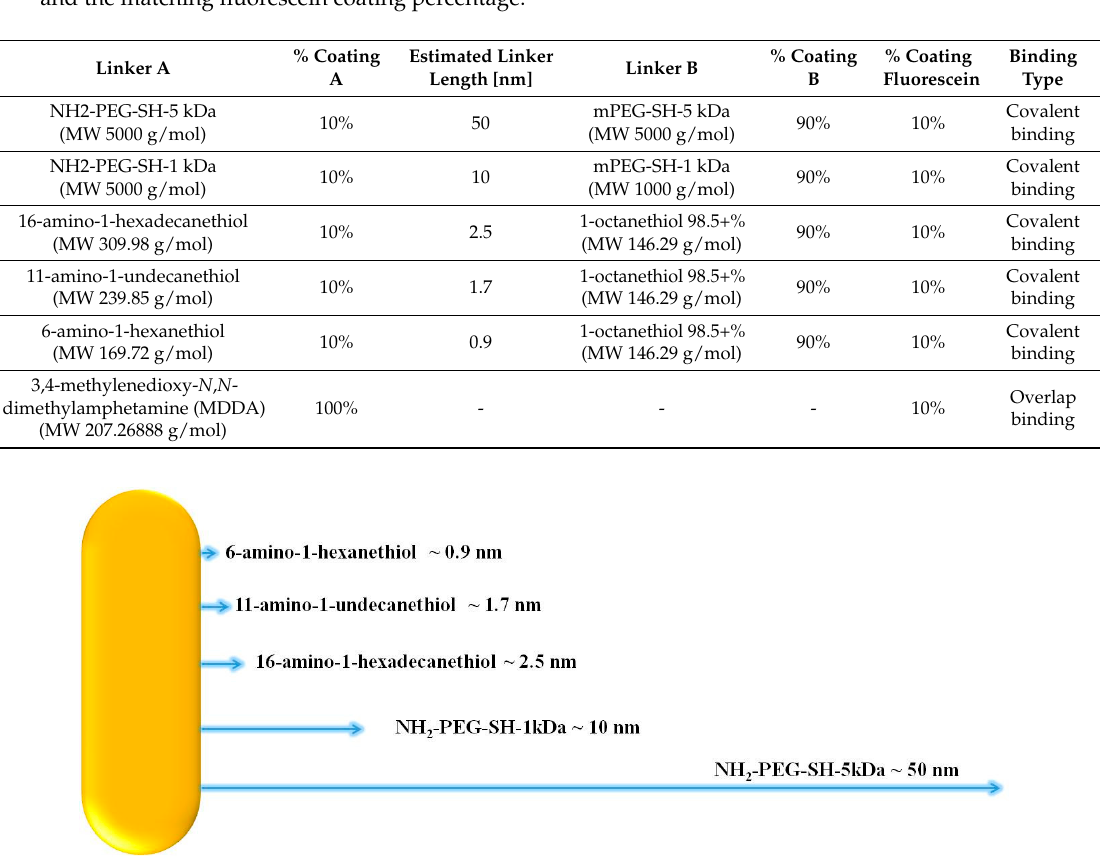
Table 3. This table lists the different linkers’ mixtures, the percentage of each linker in these mixtures and the matching fluorescein coating percentage.